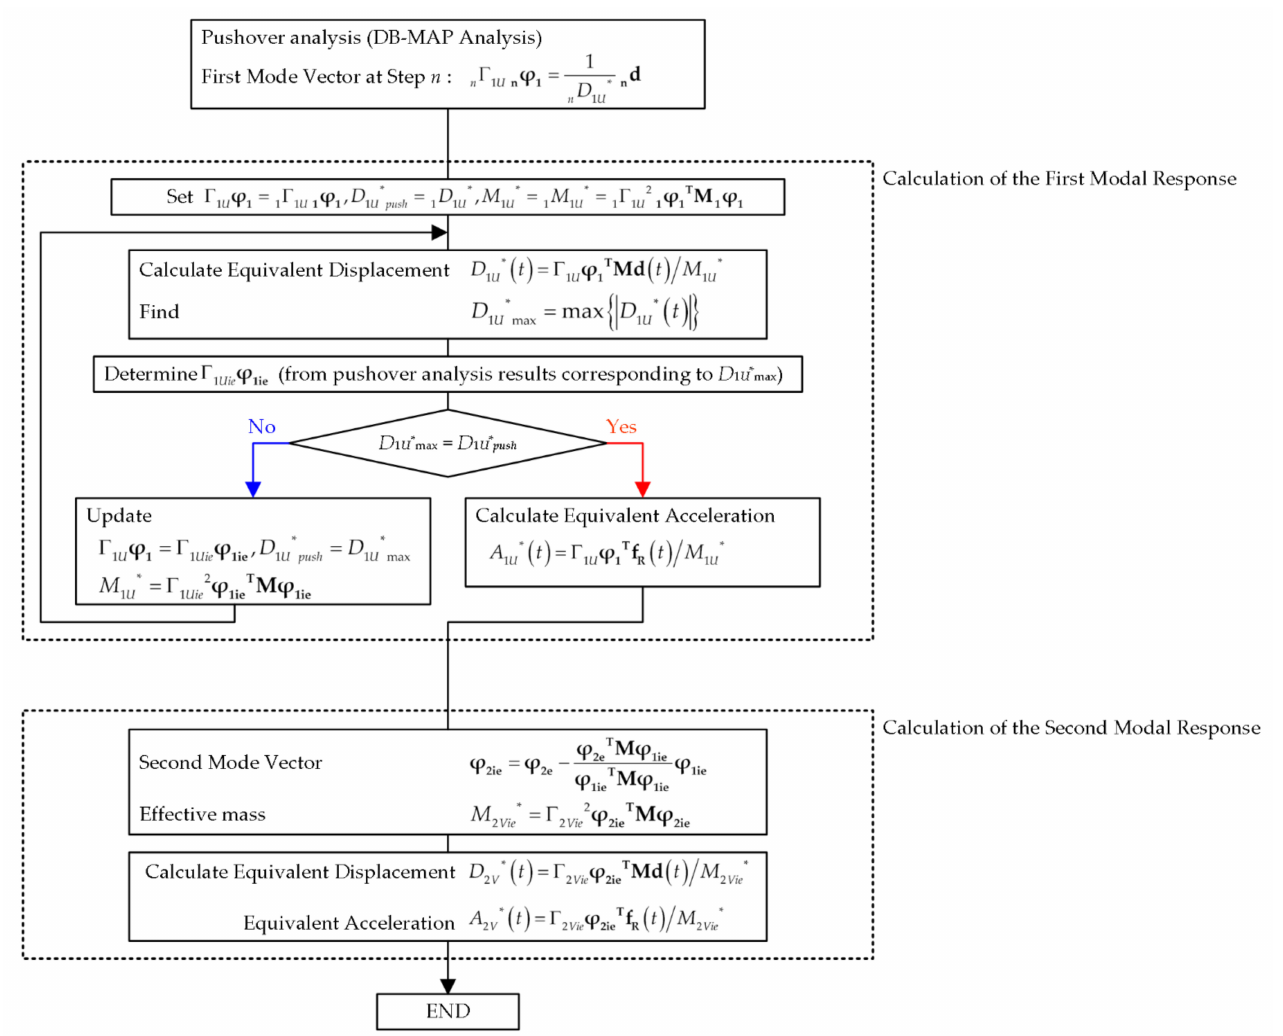
Figure 31. Calculation flow for the first and second modal